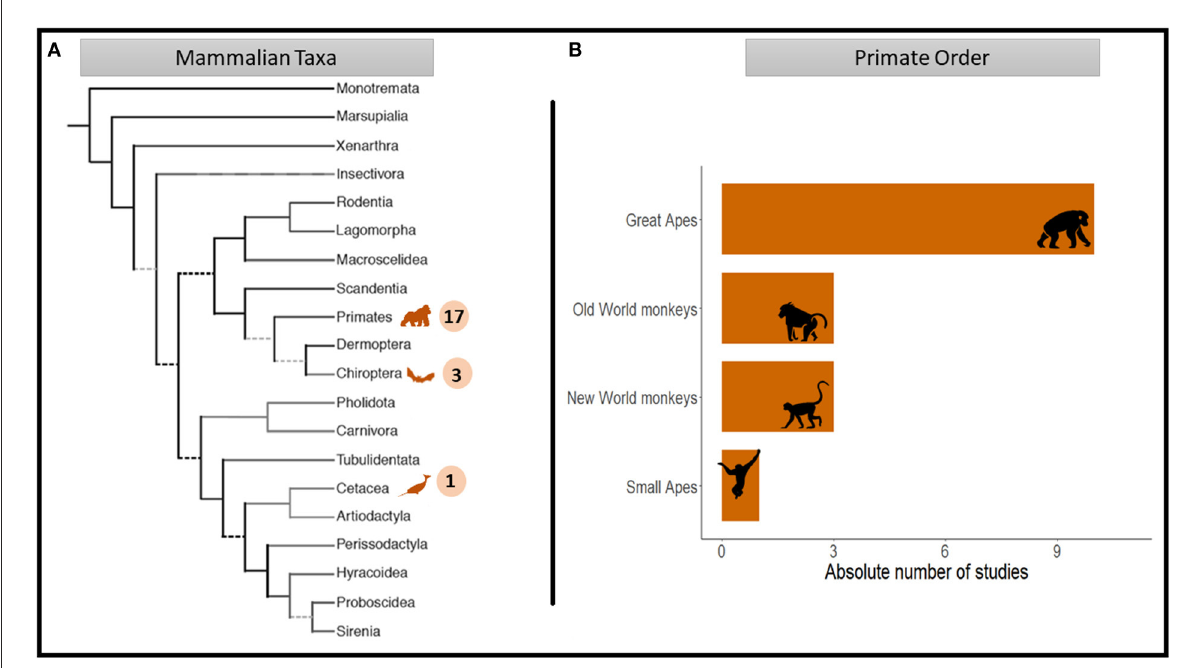
FIGURE3 Mammal orders represented in the studies reviewed as a function of the total numbers of turn-taking studies distributed across (A) mammal orders ( n = 21) and (B) the primate order ( n = 17; adapted from Figure 1A in Springer et al., 2004).